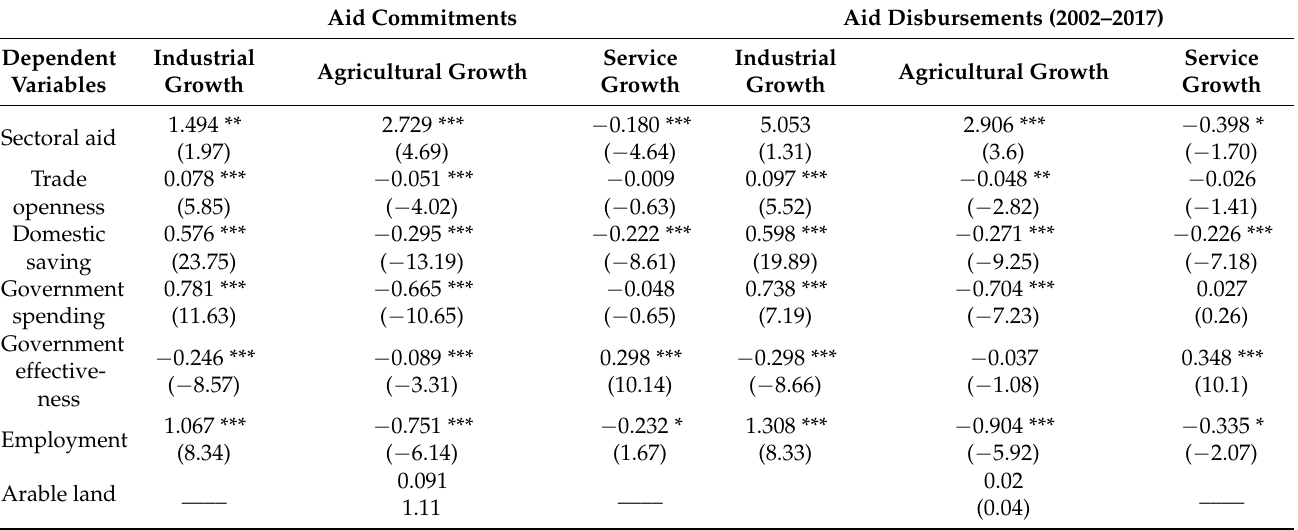
Table 2. The first specification estimation’s results (SUR for both commitments and disbursements). Aid